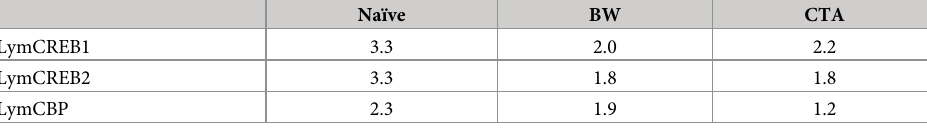
Table 2. Ratio between average values of mRNA levels (RT method 2/RT method 1) calculated by absolute